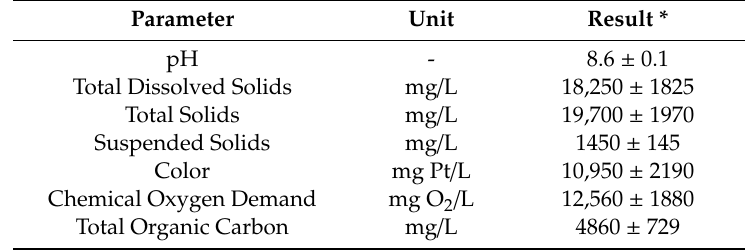
Table 1. Selected physicochemical parameters of the raw tannery wastewater. Parameter Unit Result * pH